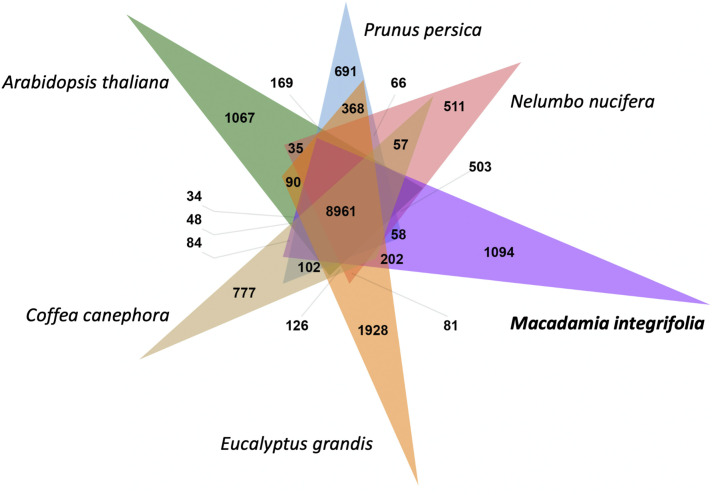
Venn diagram of orthologous gene clusters for six eudicot species including the basal eudicots M. integrifolia and N. nucifera (Proteales) and core eudicots P. persica (Rosales), A. thaliana (Brassicales), C. canephora (Gentianales) and E. grandis (Myrtales).